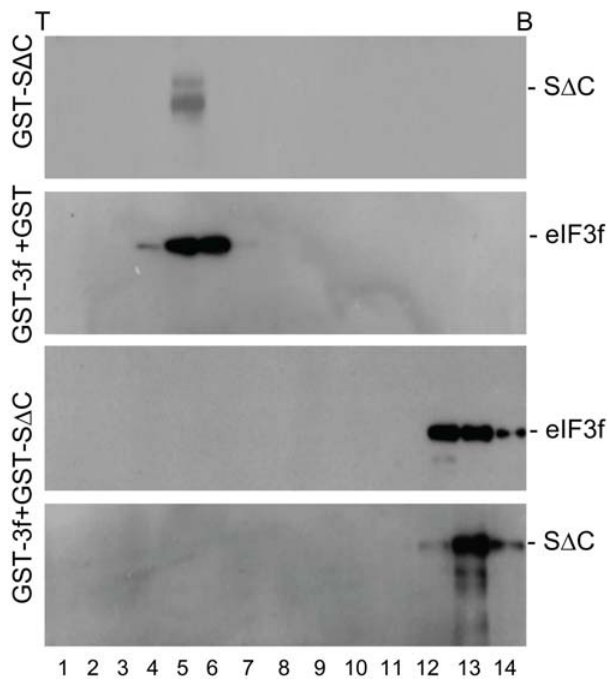
Figure 2. Co-fractionation of S D C with eIF3f in vitro in sucrose gradients. Ten micrograms each of the purified GST-S D C (top panel), GST- 3f + GST (second panel) and GST3f + GST-S D C (third and bottom panels) were loaded onto the top of 15–50% sucrose gradients and centrifuged at 40,000 g for 20 hours. Fourteen fractions were collected from the top to the bottom and analyzed by Western blot with anti-S (top and bottom panels) and anti-eIF3f (second and third panels) antibodies.